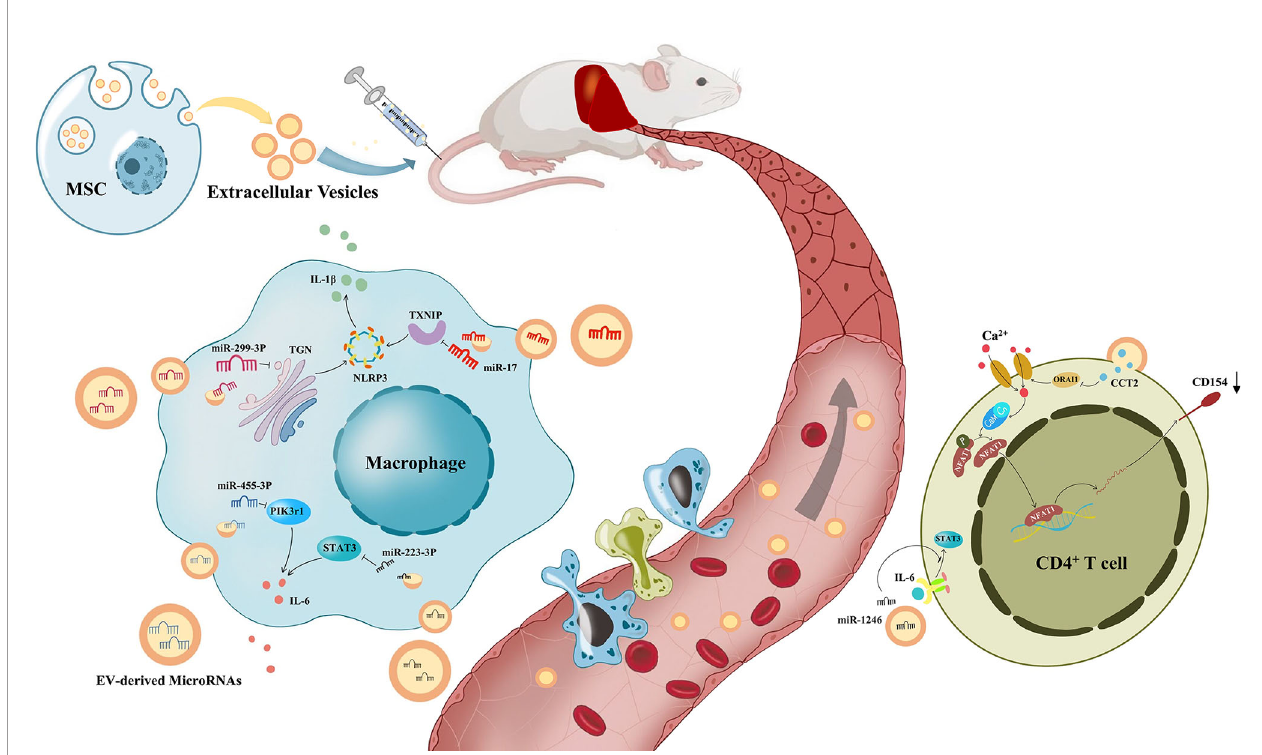
FIGURE 2 | The process of immune regulation by mesenchymal stem cell-derived extracellular vesicles on the liver. Under the modulation of Mesenchymal stem cell-derived extracellular vesicles(MSV-EVs), macrophages reduce the release of IL-6 and IL-1 b , and CD4+ T cells reduce the expression of CD154. Liver in fl ammation was improved by the immune modulation of MSC-EVs, which alleviates different kinds of liver